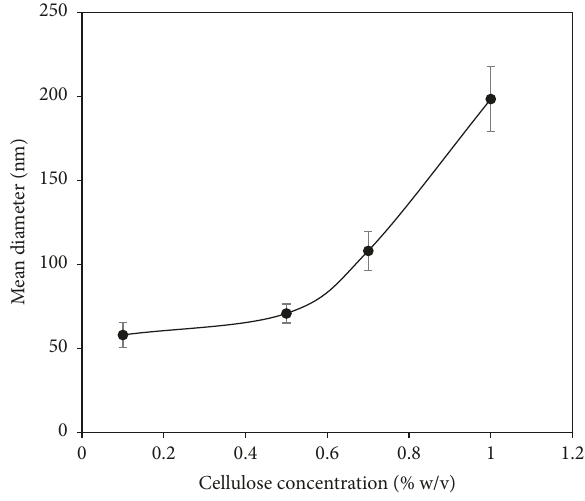
Figure 3: Effect of cellulose solution concentration on the mean diameter of nCBs